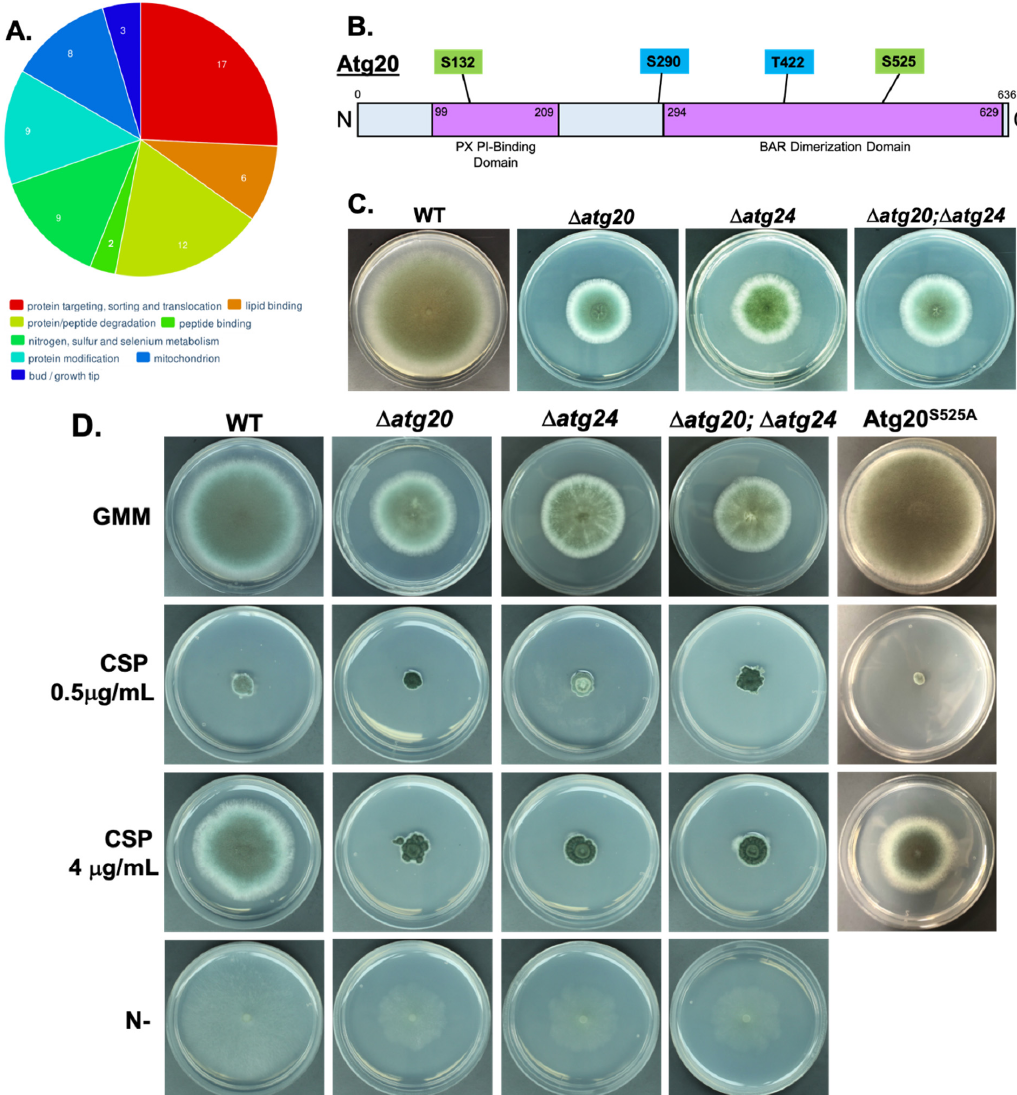
Figure 3. Atg24 interactome, Atg20 structure, deletion, and cell wall stress phenotypes. ( A ) Pie chart of enriched functional categories for Atg24-interacting proteins identified through GFP-Trap affinity purification, and LC-MS/MS analysis demonstrating at least 2-fold greater abundance in the Atg24-GFP genetic background compared to GFP control background, and statistical significance of p < 0.05 in t -test comparison. The set of interactant proteins was compared to the total set of annotated A. fumigatus proteins based on the FunCat classification systems, as analyzed using the FungiFun 2.2.8 bioinformatic software. Numbers on chart represent numbers of proteins associated with each category. Interactant proteins not associated with enriched functional categories are not represented. ( B ) Diagram of Atg20 primary amino acid sequence indicating putative functional domains, locations of canonical PKA target motif serine (S) and threonine (T) residues, and identified sites of phosphorylation (green boxes). Blue boxes indicate PKA target motifs not identified as phosphorylated. ( C ) Reduced radial growth phenotype of Atg20 deletion strain ( ∆ atg20 ), Atg24 deletion strain ( ∆ atg24 ), and Atg20/Atg24 double deletion strain ( ∆ atg20 ; ∆ atg24 ) grown on GMM agar for 4 days at 37 ◦ C, compared to the wild-type (WT) strain. ( D ) Comparison of radial growth of WT, ∆ atg20, ∆ atg24 , and ∆ atg20 ; ∆ atg24 deletion strains, as well as Atg20 serine 525 to alanine (Atg20 S525A ) mutant strain on GMM agar infused with 0, 0.5, or 4 µ g/mL caspofungin (CSP), and nitrogen free GMM for indicated strains, for 5 days at 37 ◦